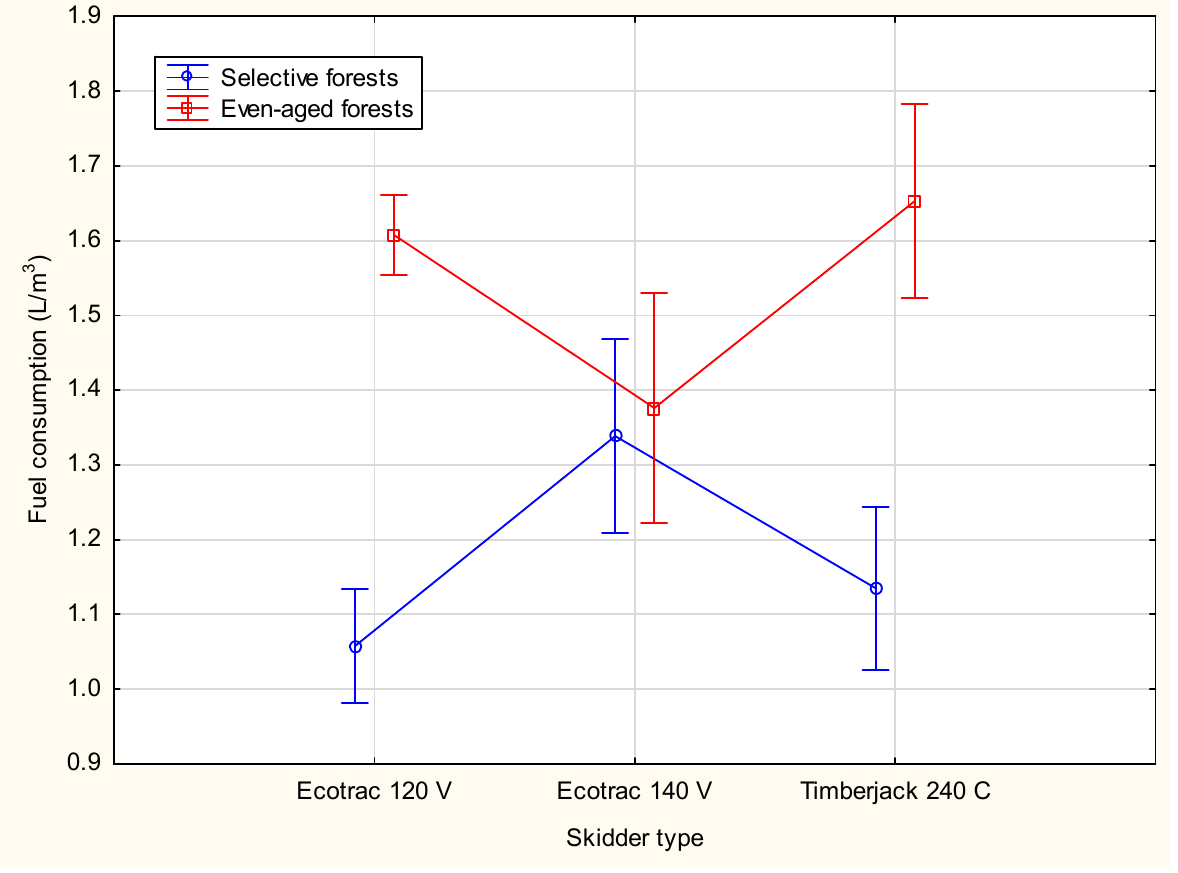
Figure 1. Fuel consumption expressed in L/m 3 . Table 3. Results of the univariate test of significance for fuel consumption with the method and skidder type as indepen- dent variables.